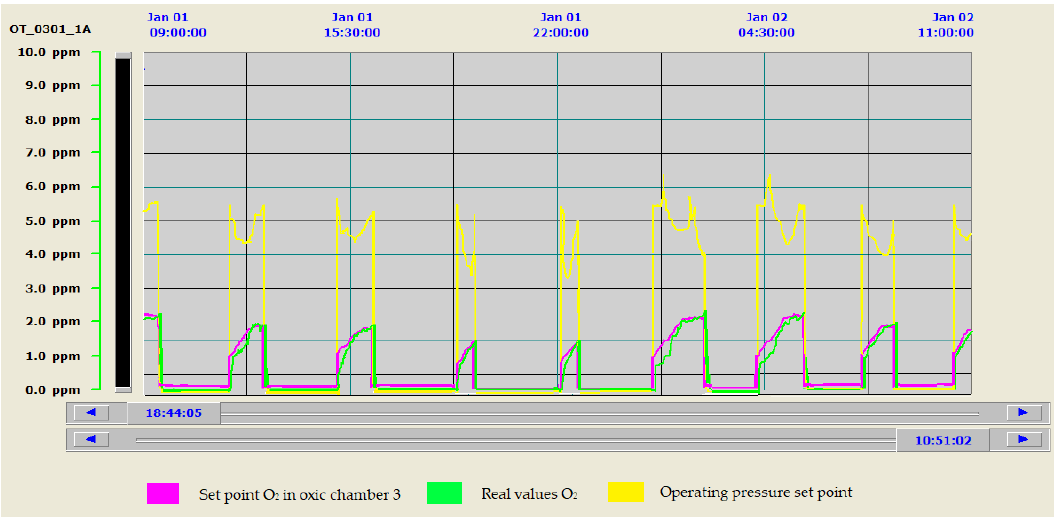
Figure 12. Oxygen evolution in Zone 3 with the new control system.